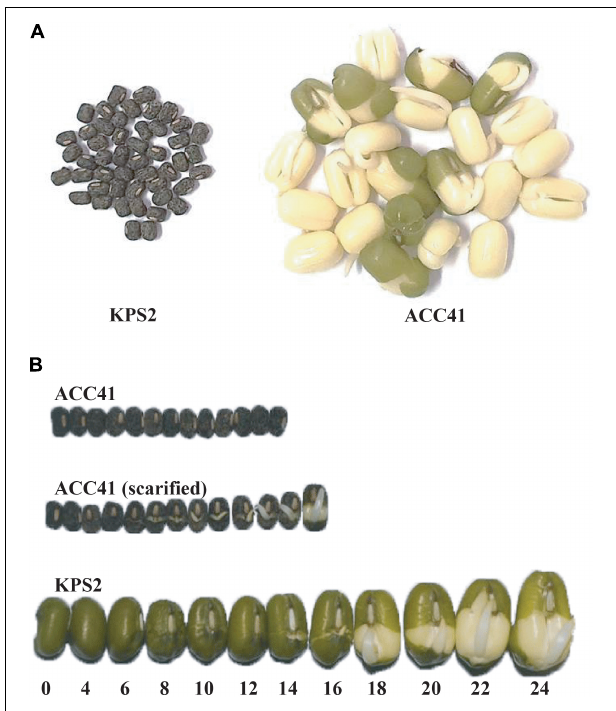
FIGURE 1 | Seed germination test of the wild mungbean ACC41 and the cultivated mungbean Kamphaeng Saen 2 (KPS2). The germination of intact seeds of ACC41 and KPS2 at 7 days after the test (A) . The germination of intact seeds of KPS2 and ACC41 and scarified seeds of ACC41 at different time series (0–24 h) (B) .